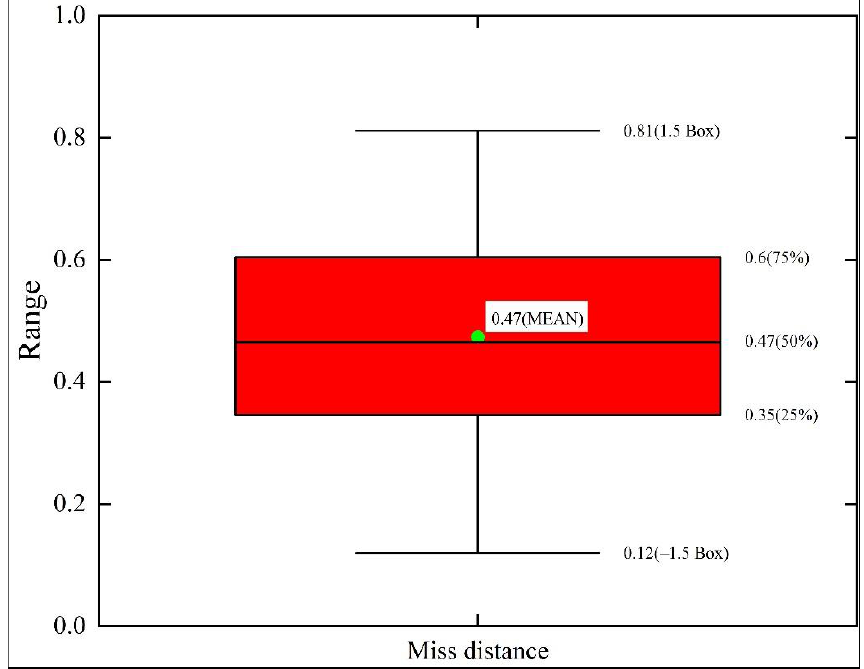
Figure 7. Miss distance of Monte Carlo simulation under Case 3.